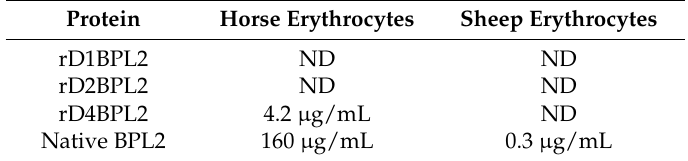
Figure 6. Hemagglutination activity of recombinant and native BPL2. Serial two ‐ fold dilutions are shown from left to right. NC, negative control. The protein concentration in the first well was 550 μ g/mL for the recombinant and 160 μ g/mL for native BPL2. Table 1. Minimum lectin concentration for agglutination of a 4% erythrocyte suspension.